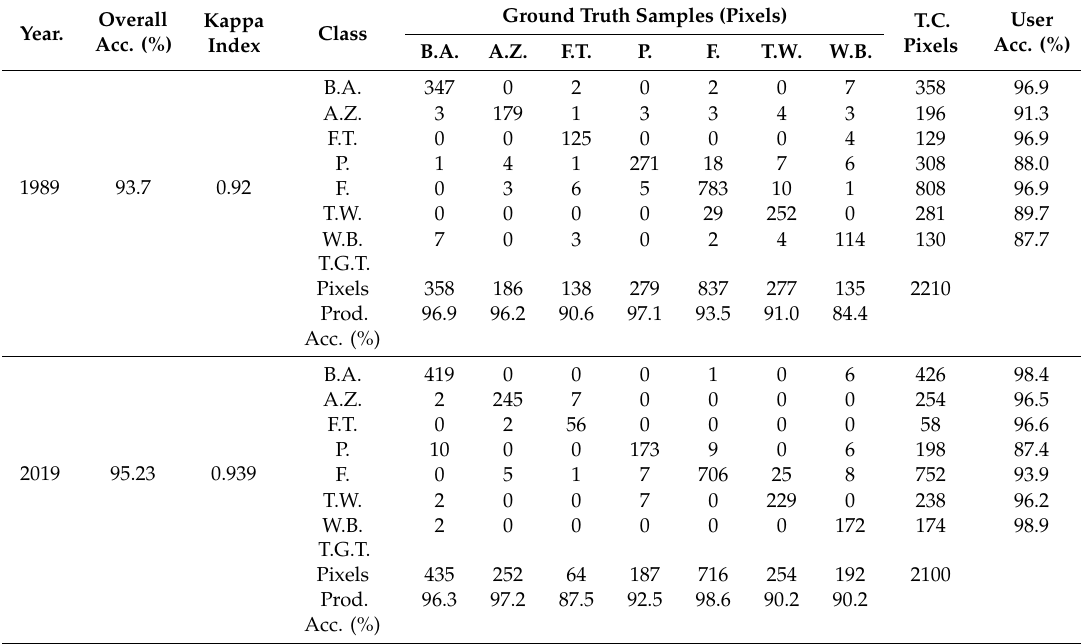
Table 1. Confusion matrix for classification accuracy